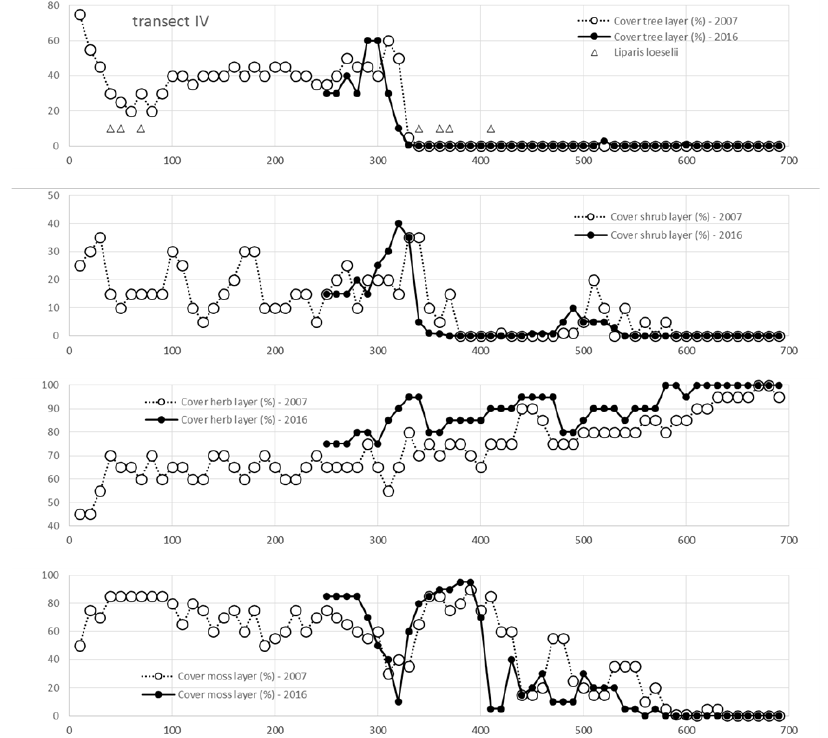
Figure 6. Cover of tree, shrub, herb and moss layers along Transect IV, in 2007 and 2016. Relevés with Liparis loeselii in 2007 are marked. The forested part of the transect was not sampled in